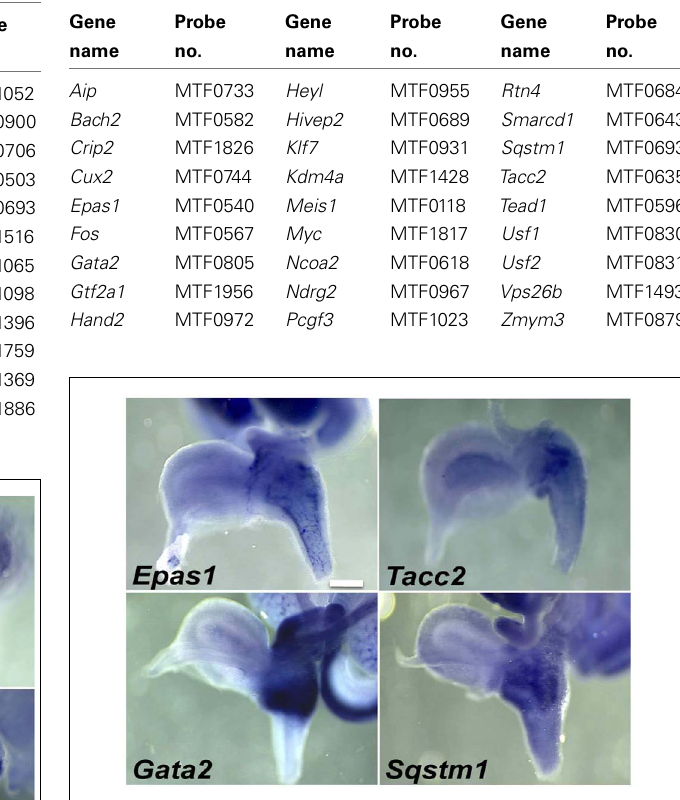
Table 2 | Genes detected in pelvic ganglia and LUT epithelium.